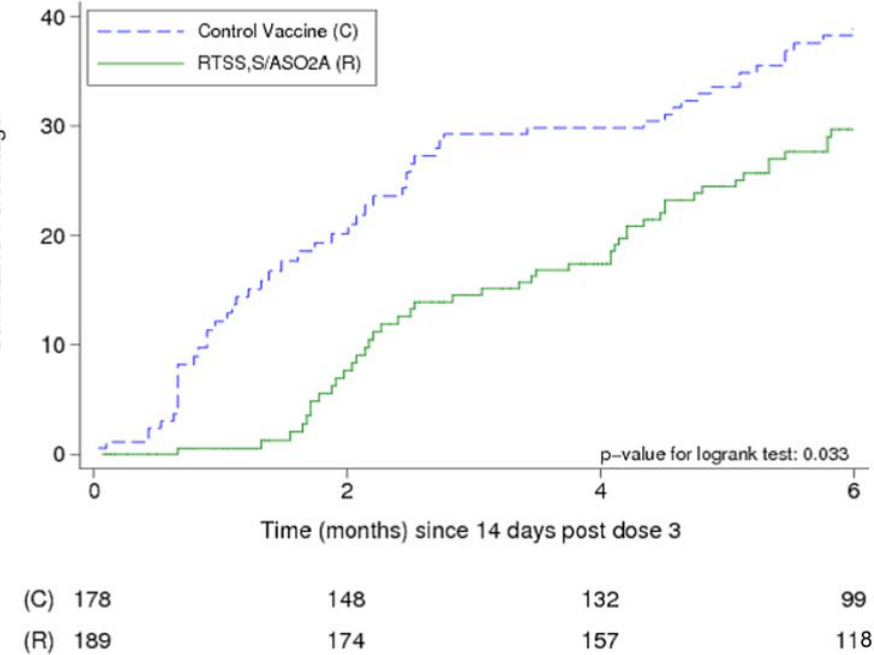
Figure 1. Kaplan-Meier survival curves for the cumulative proportion with at least one episode of clinical malaria during the double-blind and single-blind phases in cohort 2 respectively (ATP cohort).